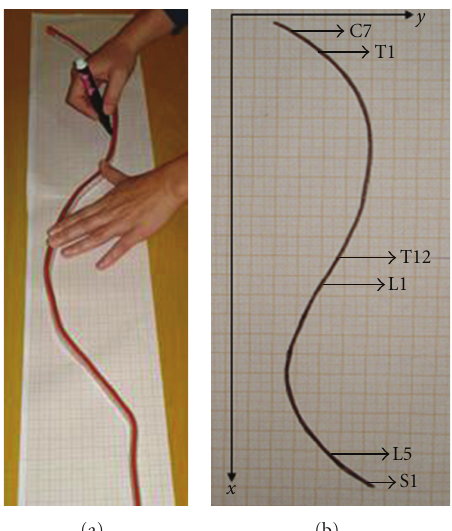
Figure 3: (a) Tracing the internal contour of the flexicurve; (b) representation of the thoracic and lumbar curvatures on graph paper showing the position of the spinous processes.